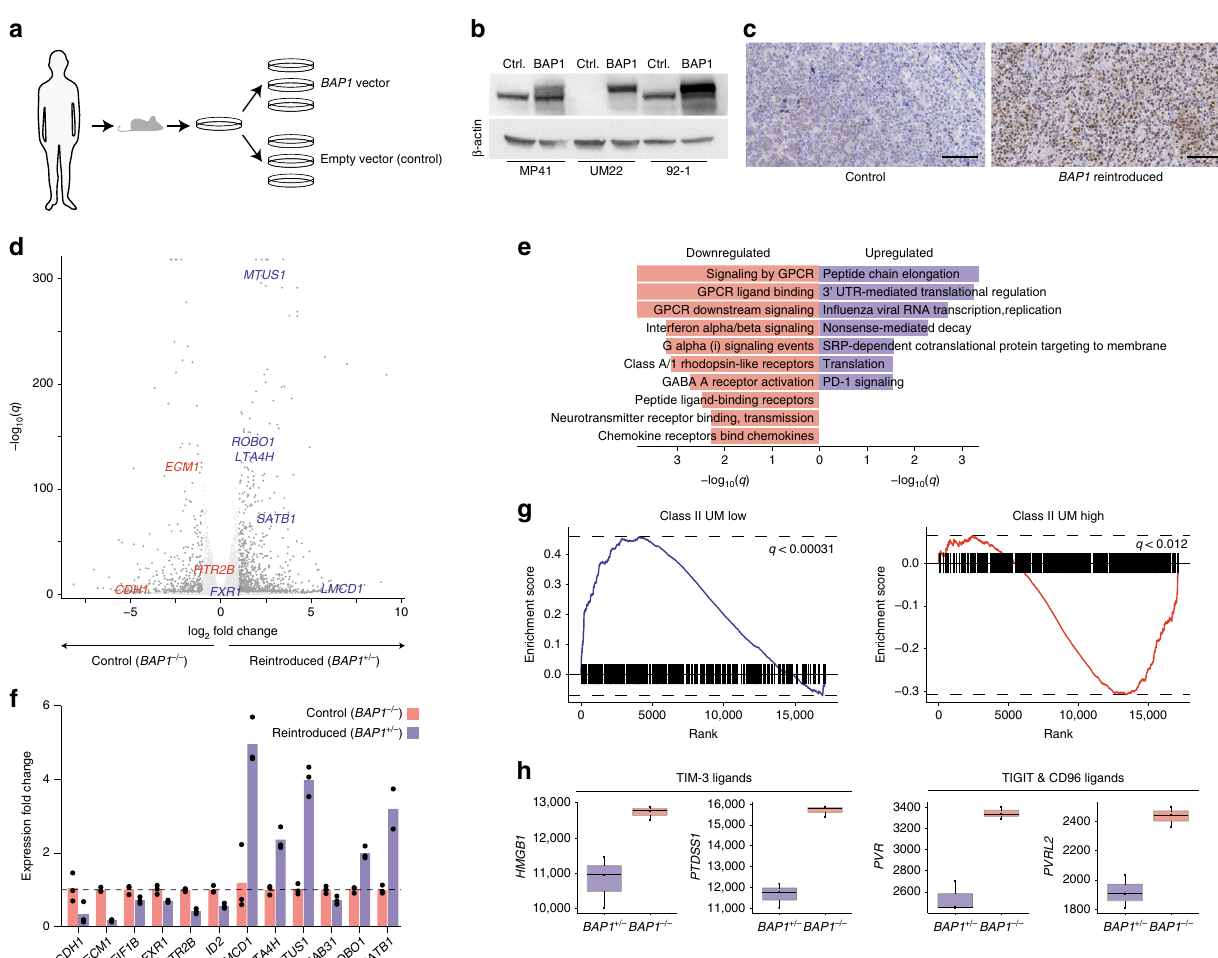
Fig. 3 Reintroduction of BAP1 into a de fi cient tumor. a Schematic representation of the experiment. Cell lines from a PDX model established from tumor UM22 were transduced with either BAP1 wild-type containing viral vectors or empty vectors and subjected to RNA sequencing. b BAP1 protein levels in empty vector controls and BAP1 -reintroduced cells. The BAP1 wild-type cell lines MP-41 and 92-1 are shown for comparison of expressed BAP1 levels with the same respective treatments. Full gel images are shown in Supplementary Fig. 5e. The western blot was repeated twice with similar results using biological replicates. Ctrl: control. c IHC staining in PDX models for BAP1 expression in empty vector controls and BAP1 -reintroduced cells. Scale bars represent 100 µ m. Shown is one staining per cell line performed on sections from tumors from one mouse out of three transplanted mice per cell line. d Differentially expressed genes for q < 0.05 and absolute log 2 fold change > 1. n = 3 independently grown samples of cells derived from either the case or control cell lines, respectively, were used and differences were assessed using DESeq2. Genes from a clinical assay distinguishing the class I and II UM subtypes are indicated 41 , with blue indicating upregulation in BAP1 -reintroduced cells, and red representing downregulation. e Top 10 enriched Reactome gene sets. f RT-qPCR results for the genes indicated in d , with n = 3 technical replicates. g Gene set enrichment analysis with respect to the MSigDB chemical and genetic perturbations category, with results from the two sets discriminating between class I and II subtypes shown 34,42 . h Downregulation of immune checkpoint ligand-related genes upon BAP1 reintroduction, as determined from RNA-seq data on n = 3 independently grown samples of cells derived from either the case or control cell lines, respectively. Horizontal lines indicate median, lower, and upper bounds of boxes represent the fi rst and third quartiles, whiskers represent the smallest/largest data point at most 1.5 times inter-quartile range from the lower and upper bound,